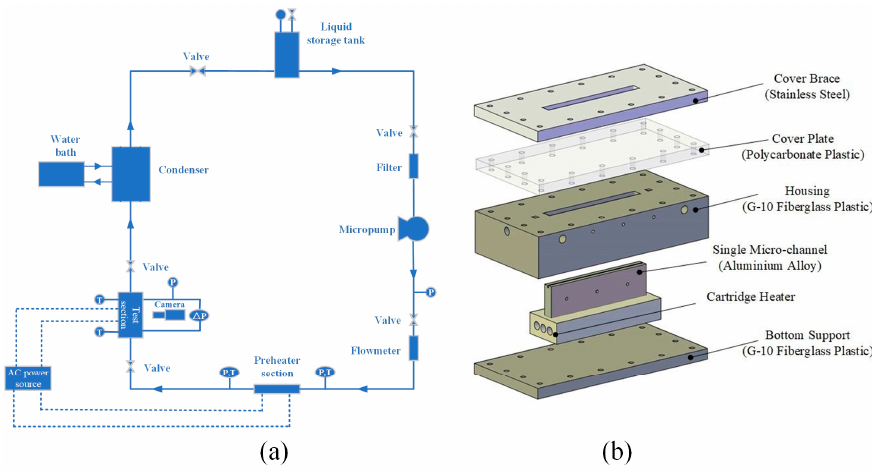
Figure 1. ( a ) Schematic diagram of the system device, ( b ) CAD images of the test section.